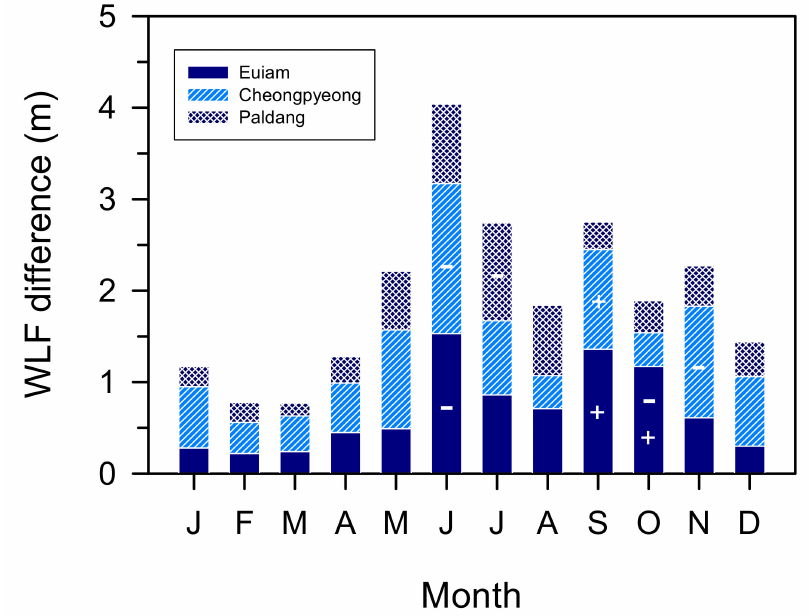
Figure 9. Spatial and temporal variability of the differences in the water-level fluctuations (WLFs) in the Euiam and Cheongpyeong Reservoirs of the North Han River and Paldang Reservoir of the Han River from January to December 2011. +, increase; − ,